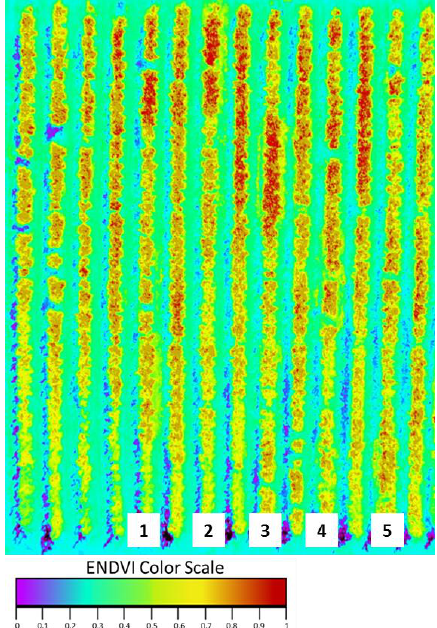
Figure 10. False color image of the experimental rows using ENDVI.